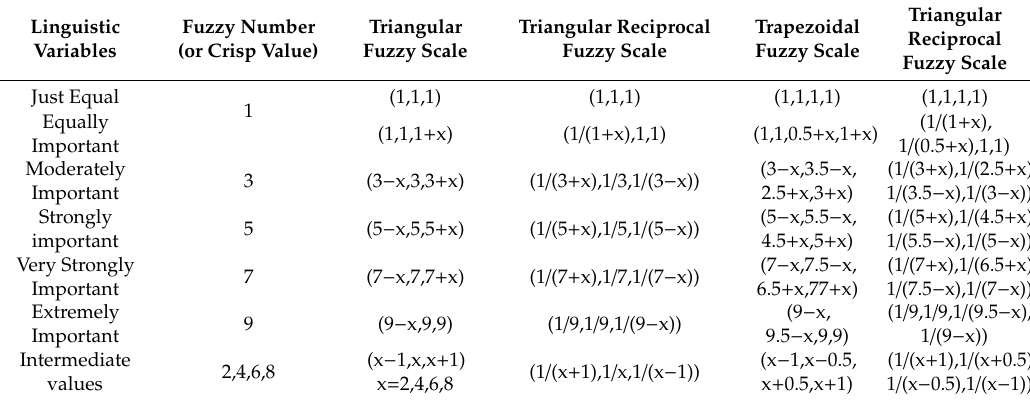
Table 1. Linguistic variables and values for pairwise matrix for triangular and trapezoidal members.